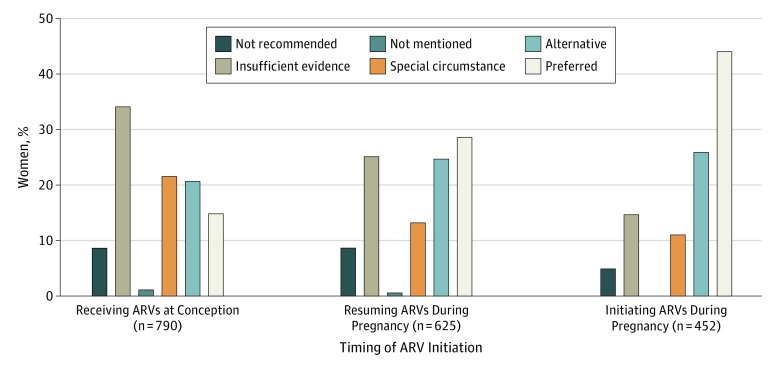
Antiretroviral (ARV) Prescribing Patterns by Timing of Initiation According to US Perinatal HIV Treatment GuidelinesA total of 790 women received ARVs at conception, 625 resumed ARVs during pregnancy, and 452 initiated ARVs during pregnancy.